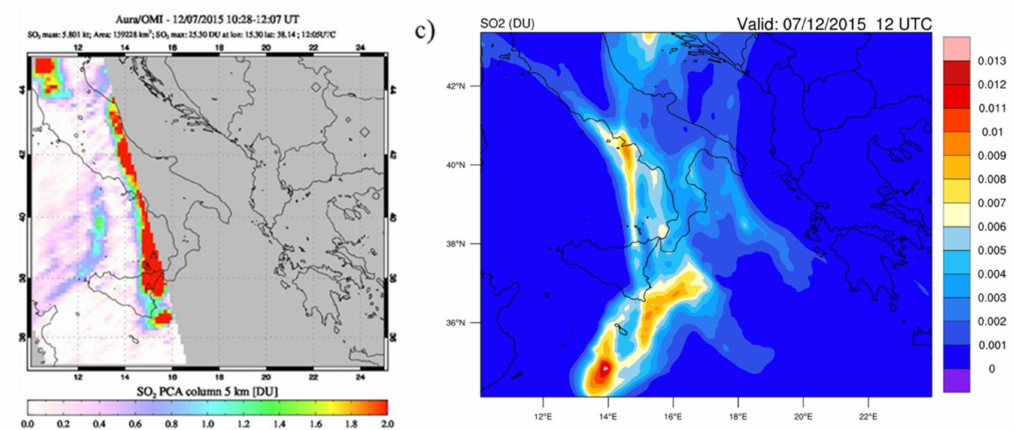
Figure 8. Comparison between the results of the daily data acquired by the Aura satellite (left) and the simulations performed with the WRF–Chem model (right), relative to the transport of SO 2 . The maps referring to the days of December 4th at 13:00 UTC ( a ), December 6th at 11:00 UTC ( b ), and December 7th at 12:00 UTC ( c ) were chosen.